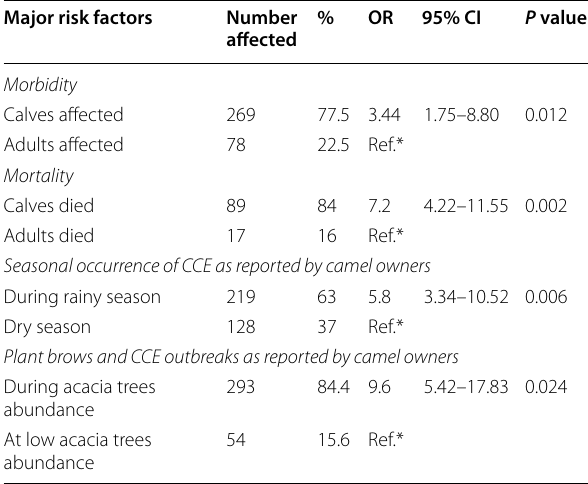
Table 3 The epidemiological aspect of CCE outbreaks in Arero